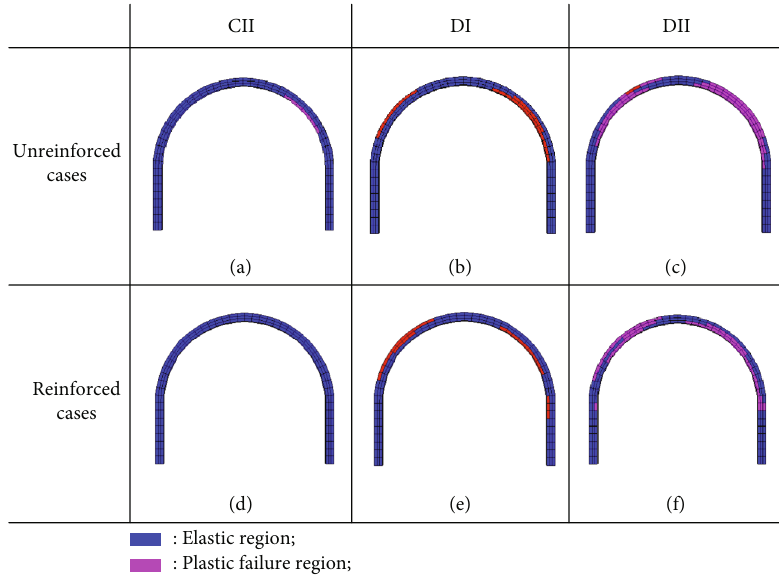
Figure 9: Plastic failure region on lining concrete for tunnel constructed by FM.